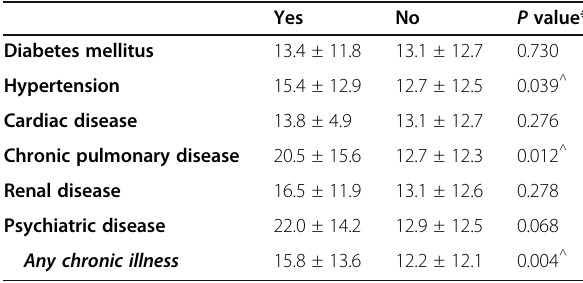
Table 2 Post-COVID-19 symptom score in patients according to comorbidities ( n =